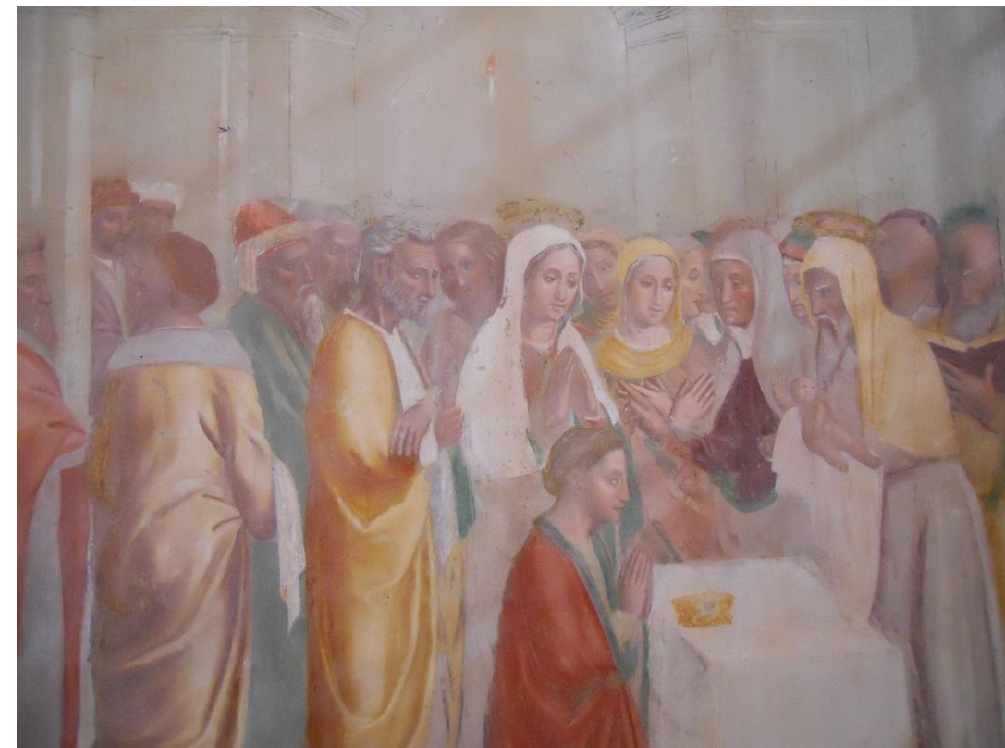
Figure 5. The zoomed